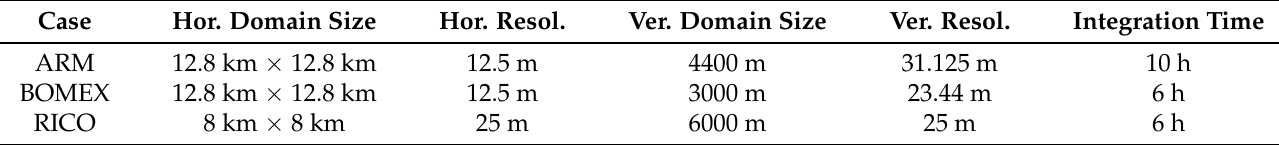
Table 1. Horizontal and vertical domain size, horizontal and vertical resolution, and integration time for the LES runs. Case Hor. Domain